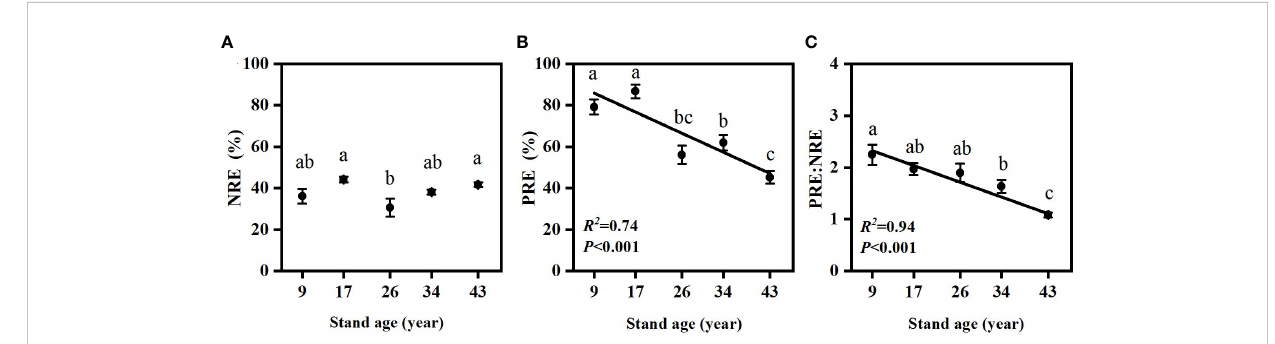
FIGURE 5 Changes in needle N resorption ef fi ciency (A) , needle P resorption ef fi ciency (B) and PRE:NRE (C) in Pinus massoniana plantations with different stand ages. Different lowercase letters indicated signi fi cant differences among the stand ages ( p